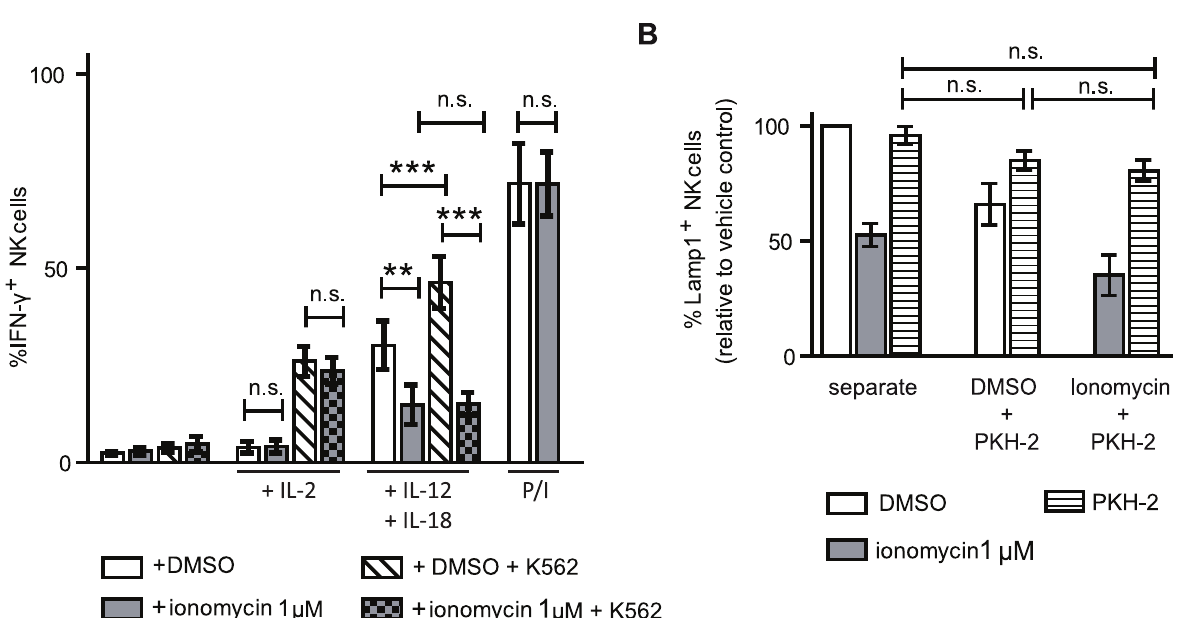
Fig 3. Ionomycin treated NK cells were unable to secrete IFN- γ as efficiently as control cells, and they do not secrete immunosuppressive cytokines. ( A ) IFN- γ production by NK cells was analyzed by flow cytometry after a 6 hours accumulation in the presence of 2.5 μ M monensin. Cells were unstimulated, stimulated with 50 U/mL IL-2. or 10ng/mL IL-12 plus 10 ng/mL IL-18 during the resting day, and left alone or cocultured with K562 target cells during 6 hours. PMA/ionomycin stimulation during 4 hours of NK cells was also used to measure their potential ability to produce IFN- γ ( n = 6 ). Two tailed paired Student's T test analysis. ( B ) Culture of autologous NK cells alone (separate) or in co-culture with DMSO control or ionomycin treated NK cells had no effect on the ability of these NK cells to respond to targets ( n = 4 ). Paired one way ANOVA analysis and Tukey's multiple comparison test. The data show mean ± SEM. ** p < 0.01, *** p < 0.001, n . s .: non-significant.